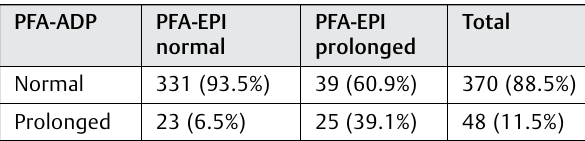
Table 3 Comparison of PFA-EPI with PFA-ADP for normal and